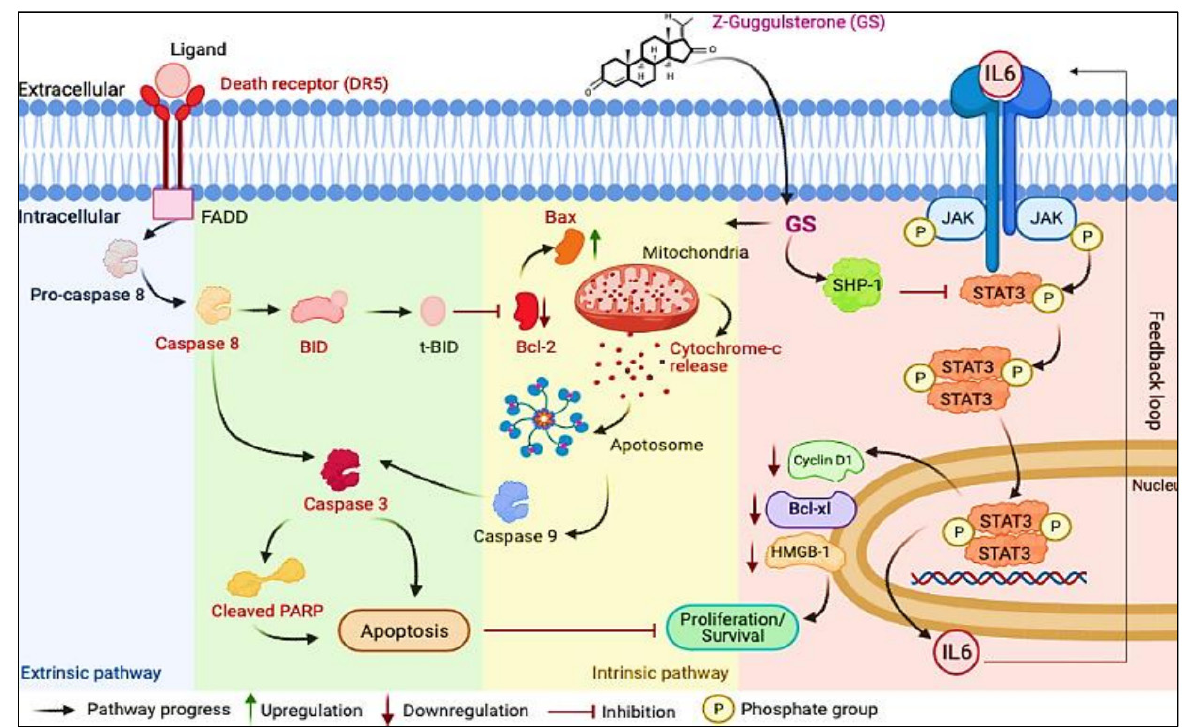
Figure 9. Schematic diagram representing a model for GS-induced cytotoxicity in MM cells plausibly through the suppression of the JAK/STAT signaling pathway and induction of apoptosis.